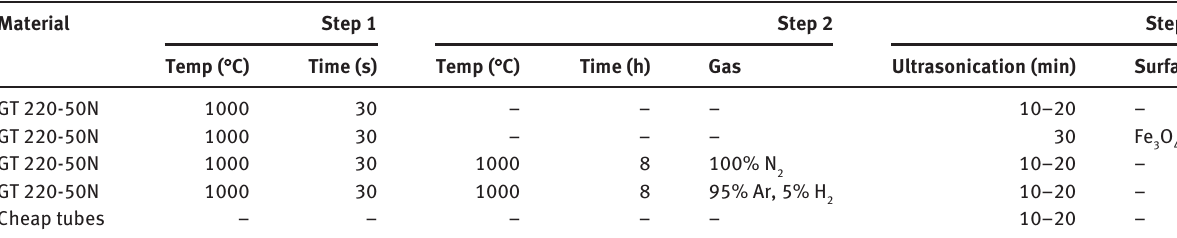
Table 1 Graphenes summarized by production method, surface coating, and